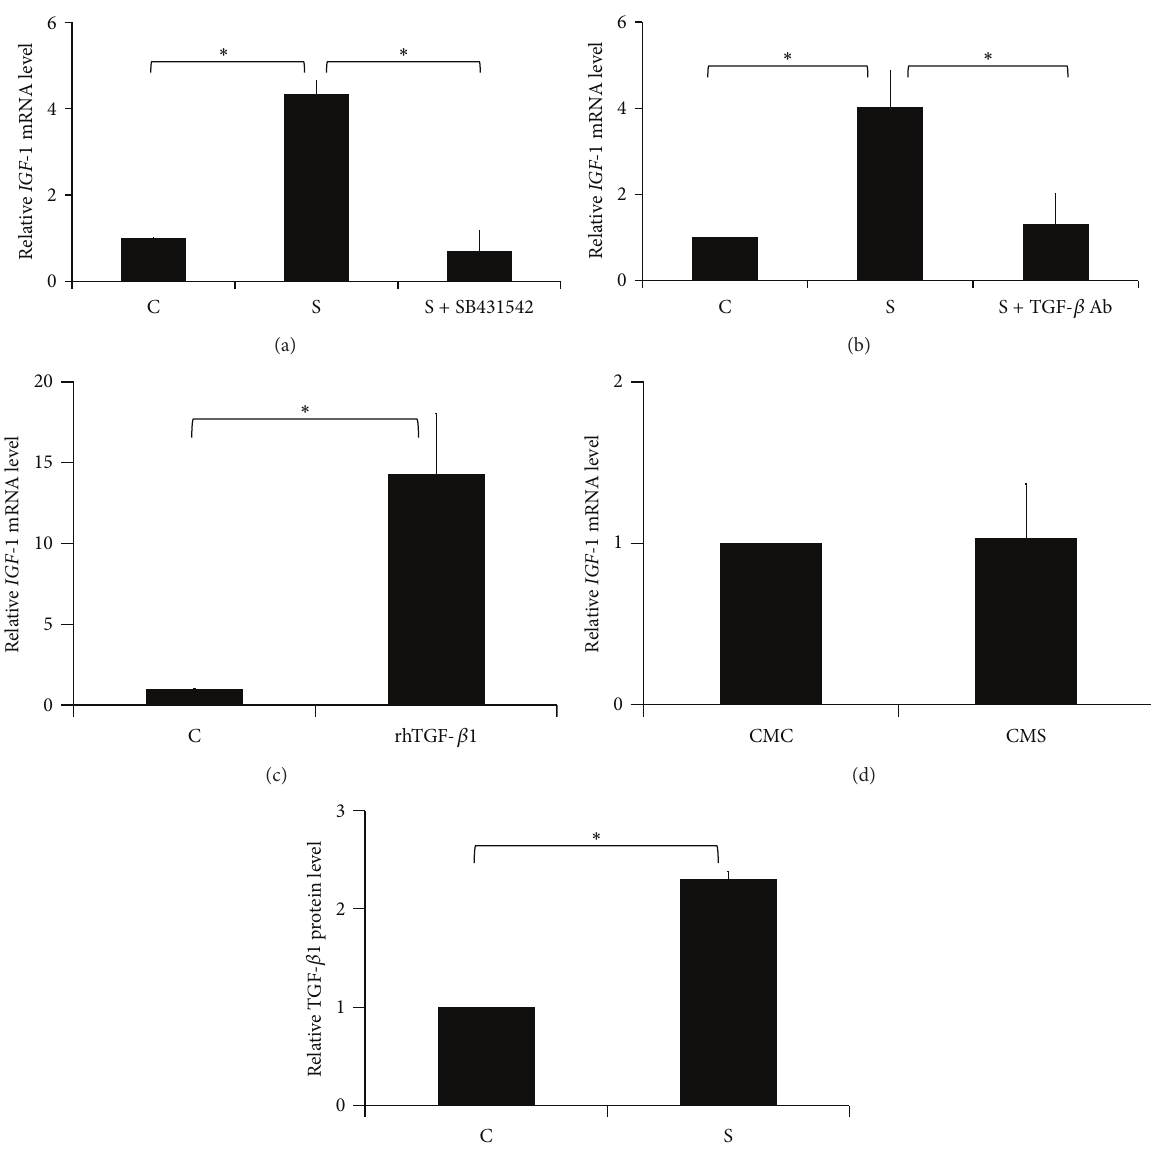
Figure 3: TGF- 𝛽 1 related to intermittent mechanical stress-induced IGF-1 expression. (a) SB431542 (10 𝜇 M) or (b) TGF- 𝛽 1 neutralizing antibody (Ab) (5 𝜇 g/mL) was used to pretreat HPDLs 30 min before applying the intermittent mechanical stress for 24h. The IGF-1 expression was measured by real-time PCR. (c) IGF-1 mRNA levels were examined after HPDLs were treated with rhTGF- 𝛽 1 (2 ng/mL) for 24 h. (d) HPDLs were treated with cell culture medium from intermittent mechanical stress-treated group (CMS) or untreated group (CMC) 24 h. The IGF-1 mRNA levels were determined by real-time PCR. (e) The TGF- 𝛽 1 protein in whole cell lysate was measured by ELISA assay. Asterisks indicated statistically significant difference. C: the control condition; S: the intermittent mechanical stress treatment